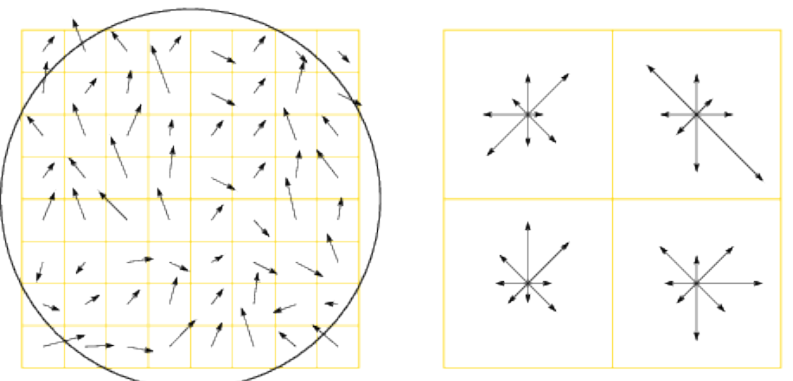
Figure 8. Keypoint descriptor computation. On the left image, the arrows represent the gradients and direction of neighbors around a keypoint. The circle displays the Gaussian weight function. The right image shows a 4 × 4 sub-region keypoint descriptor resulted from the sum of orientations and intensities from the left histogram. The arrow size reflects the total of gradient from that orientation within the region. Adapted from